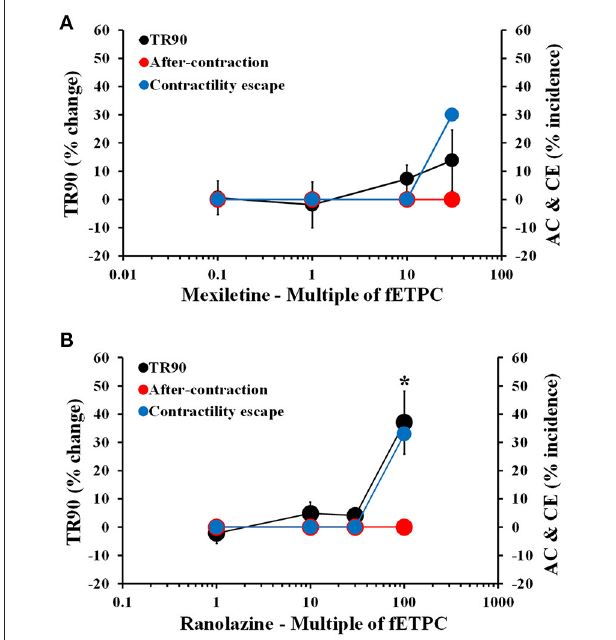
FIGURE 5 | Mean % change in TR90 and AC & CE % incidence when cardiomyocytes were treated with mexiletine (A) and ranolazine (B) . * P < 0.05 vs. values from vehicle.